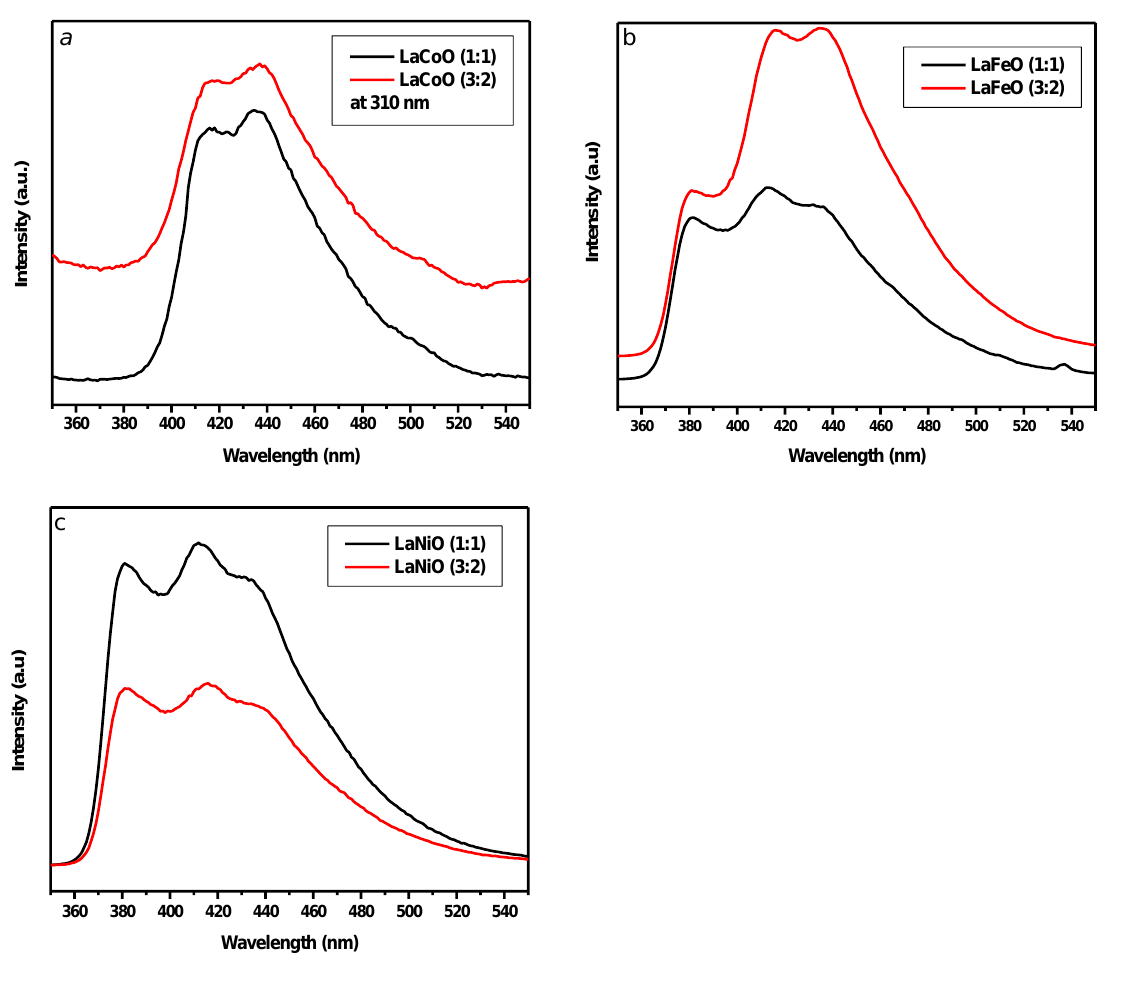
Figure 8. PL spectra of La composites for ( a ) LaCoO 3 , ( b ) LaFeO 3 , and ( c ) LaNiO 3 with ratios of 1:1 and 2:3 ratios.